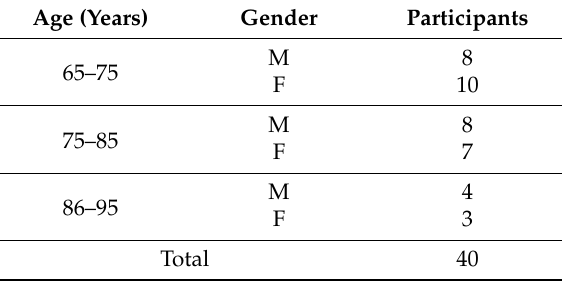
Table 1. Demographics.